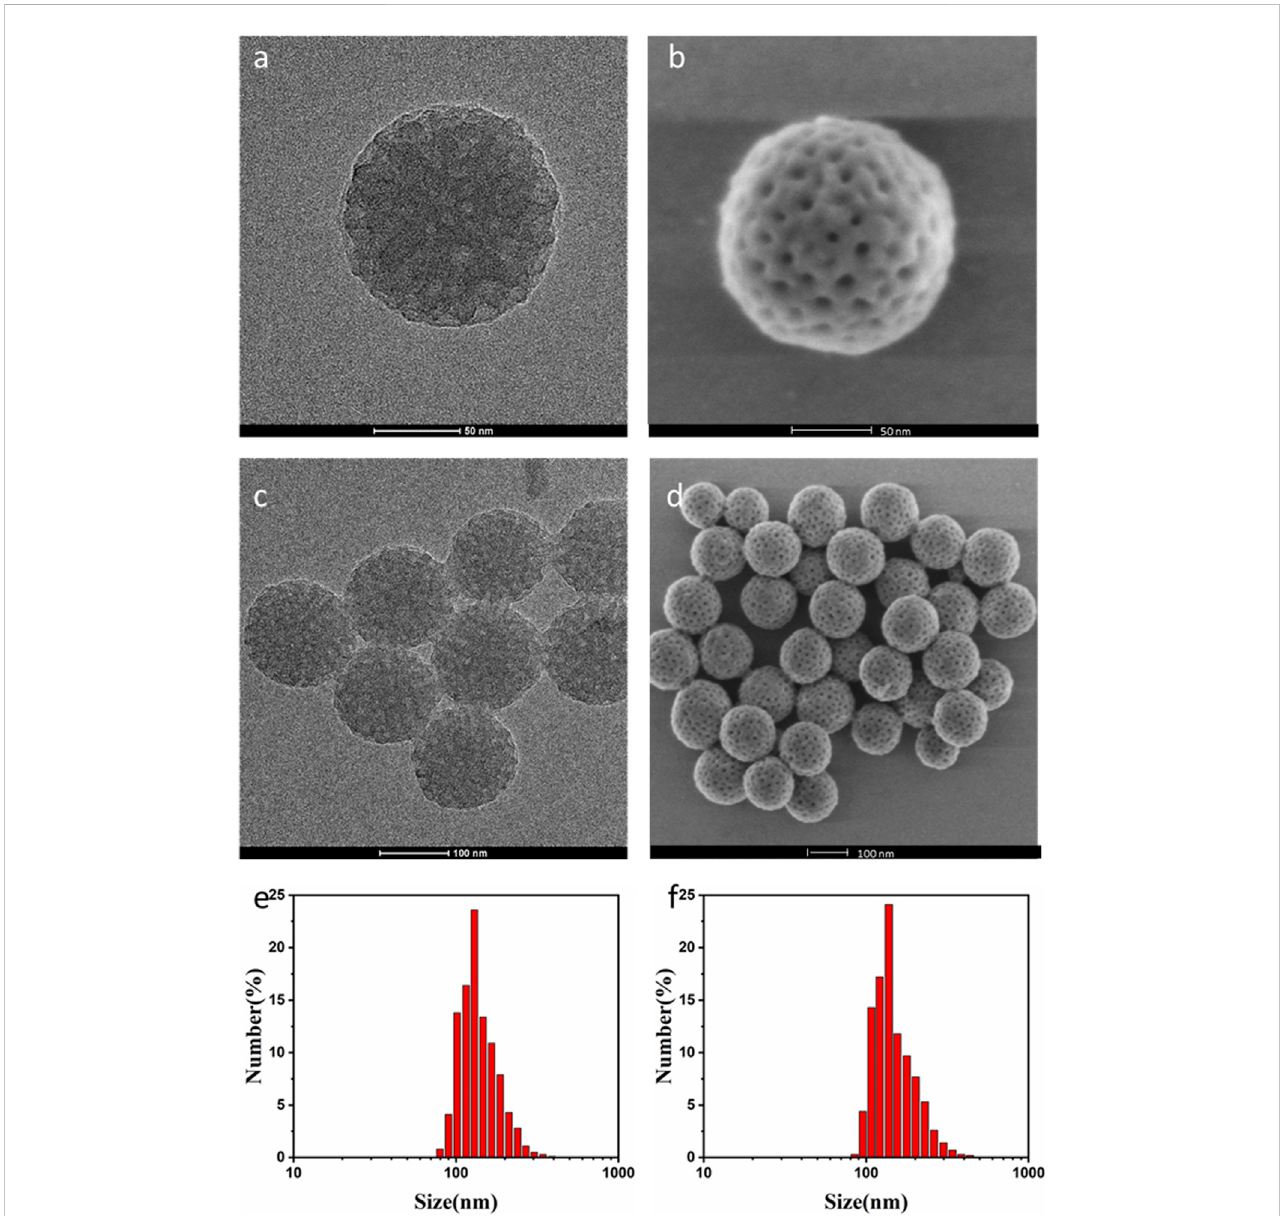
FIGURE 2 (A) TEMimageofmPDAsinglenanoparticles; (B) SEMimagesofmPDAsinglenanoparticles; (C) TEMimageofmPDAnanoparticles; (D)